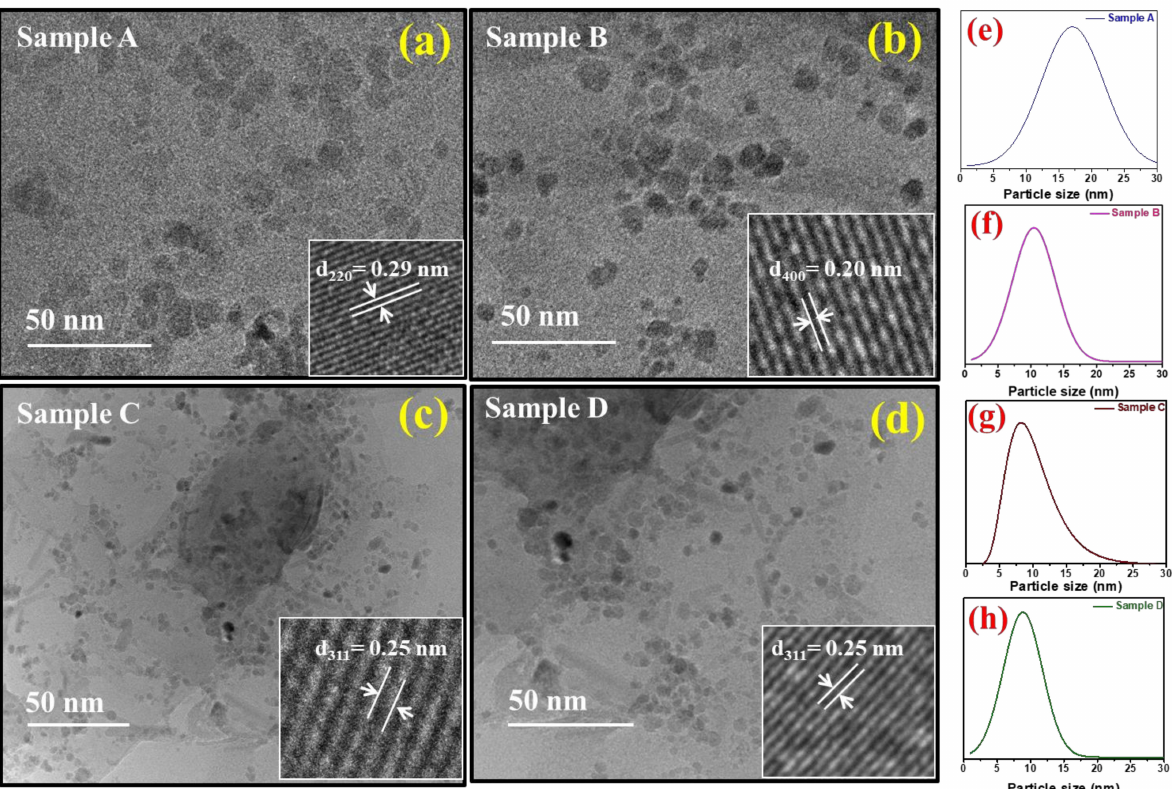
Figure 6. ( a – d ) TEM micrographs of samples A, B, C, and D, respectively. Inset ( a – d ) HRTEM images showing interplanar distances 0.29 nm, 0.20 nm, and 0.25nm corresponding to planes (220), (400), and (311), respectively. ( e – h ) Size distribution graph of samples A, B, D (Gaussian distribution) and sample C (log-normal